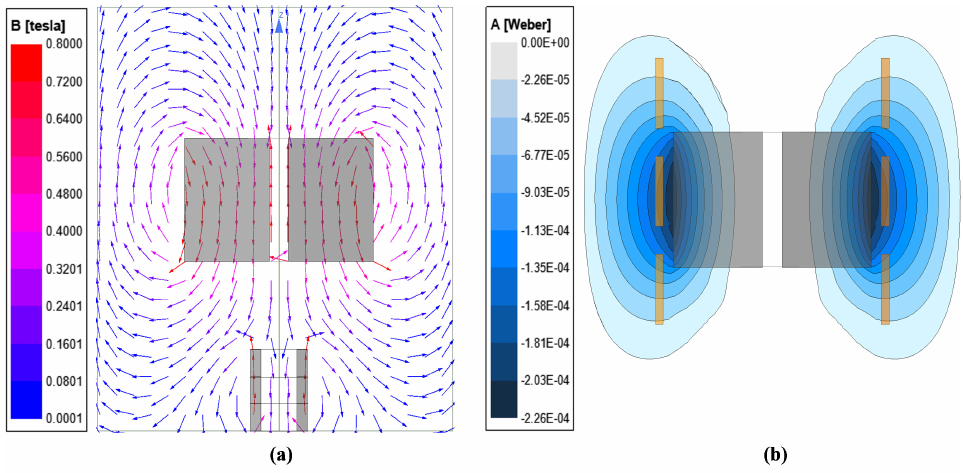
Figure 4. ( a ) Magnetic field vectors for EH3. ( b ) Magnetic flux linkage for